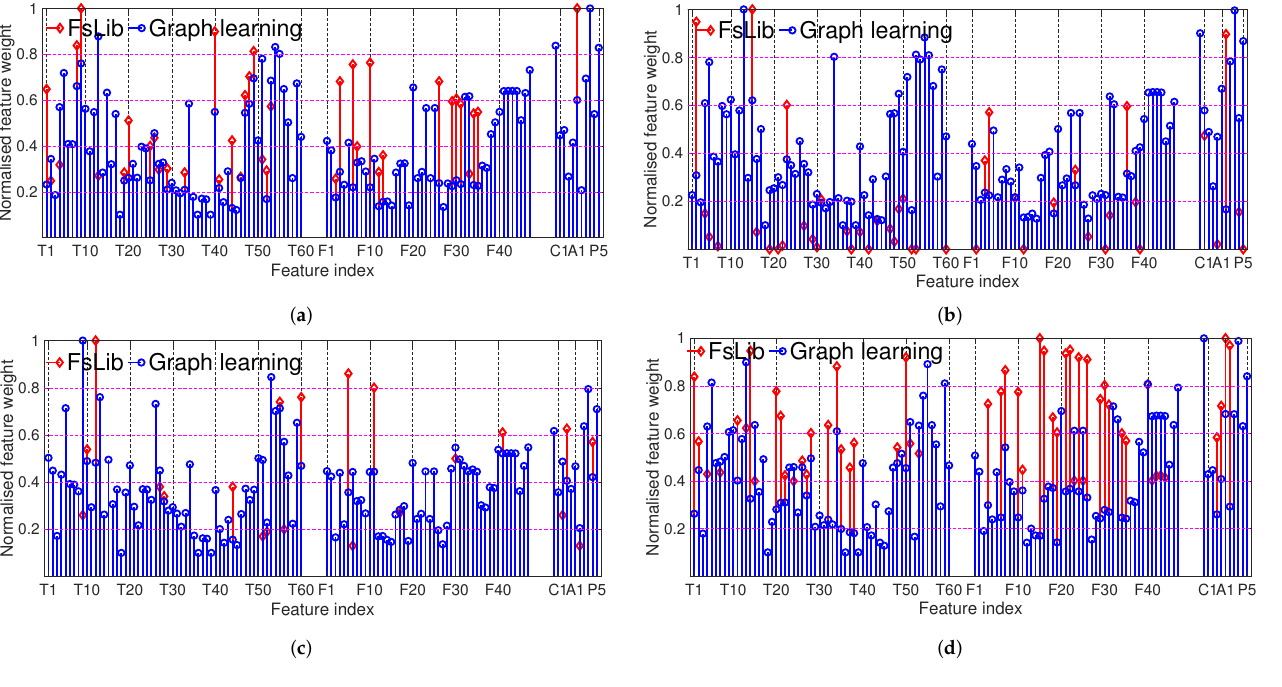
Figure 4. Normalised feature weights from the resulting set o for all 4 classes. Features of high importance include temporal (T), Spectral (F), Cepstrum (C), Acoustic (A), Polarity (P). ( a ) Feature weight for rockfall. ( b ) Feature weight for slide quake. ( c ) Feature weight for earthquake. ( d ) Feature weight for noise.